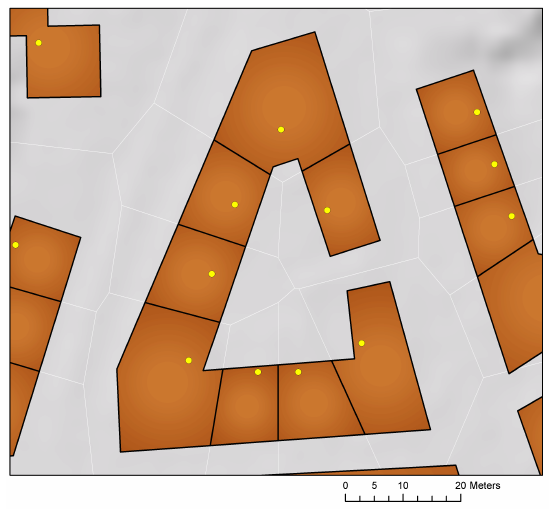
Fig. 2. Buildings and Voronoi polygons to represent dwellings based on the GWS points.